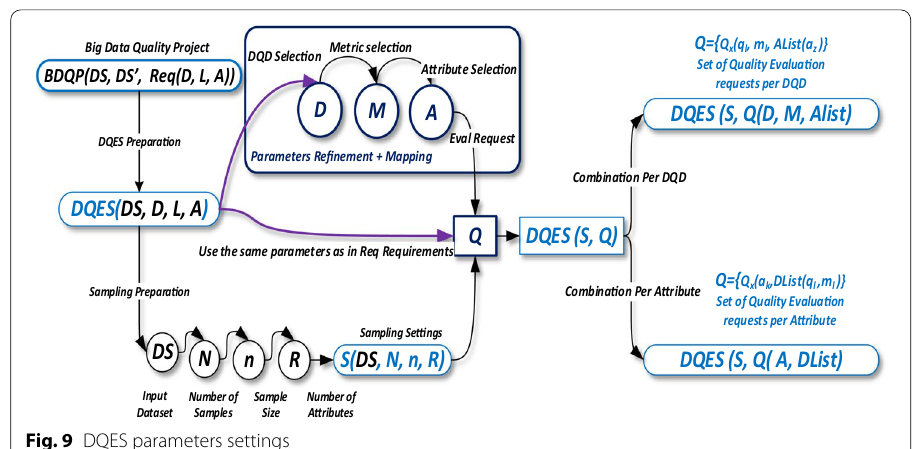
Fig. 9 DQES parameters settings